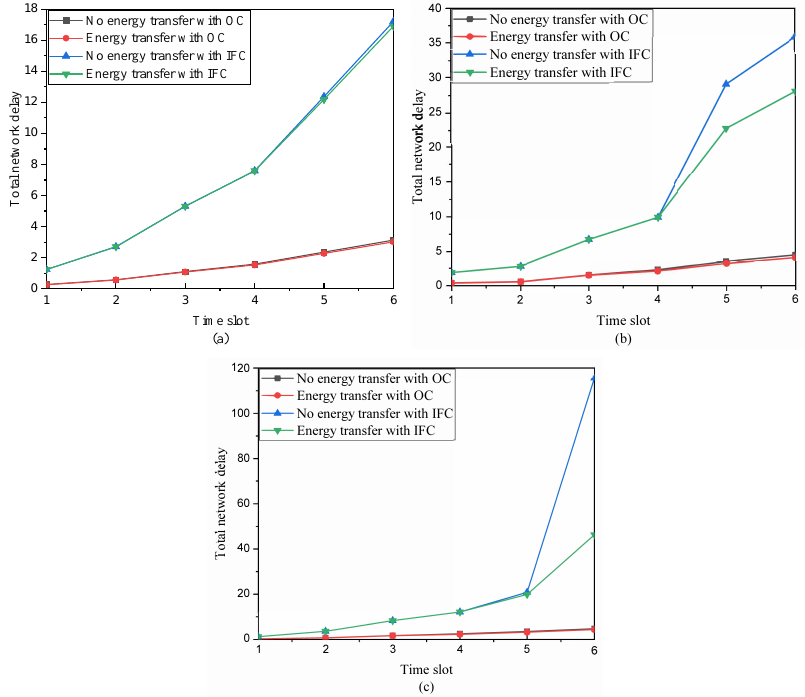
Figure 3. The total delay of energy harvesting WSNs over time: ( a ) Data flow d ∼ U ( 0,0.5 ] ; ( b ) data flow d ∼ U ( 0,1 ] ; ( c ) data flow d ∼ U ( 0,1.5 ]